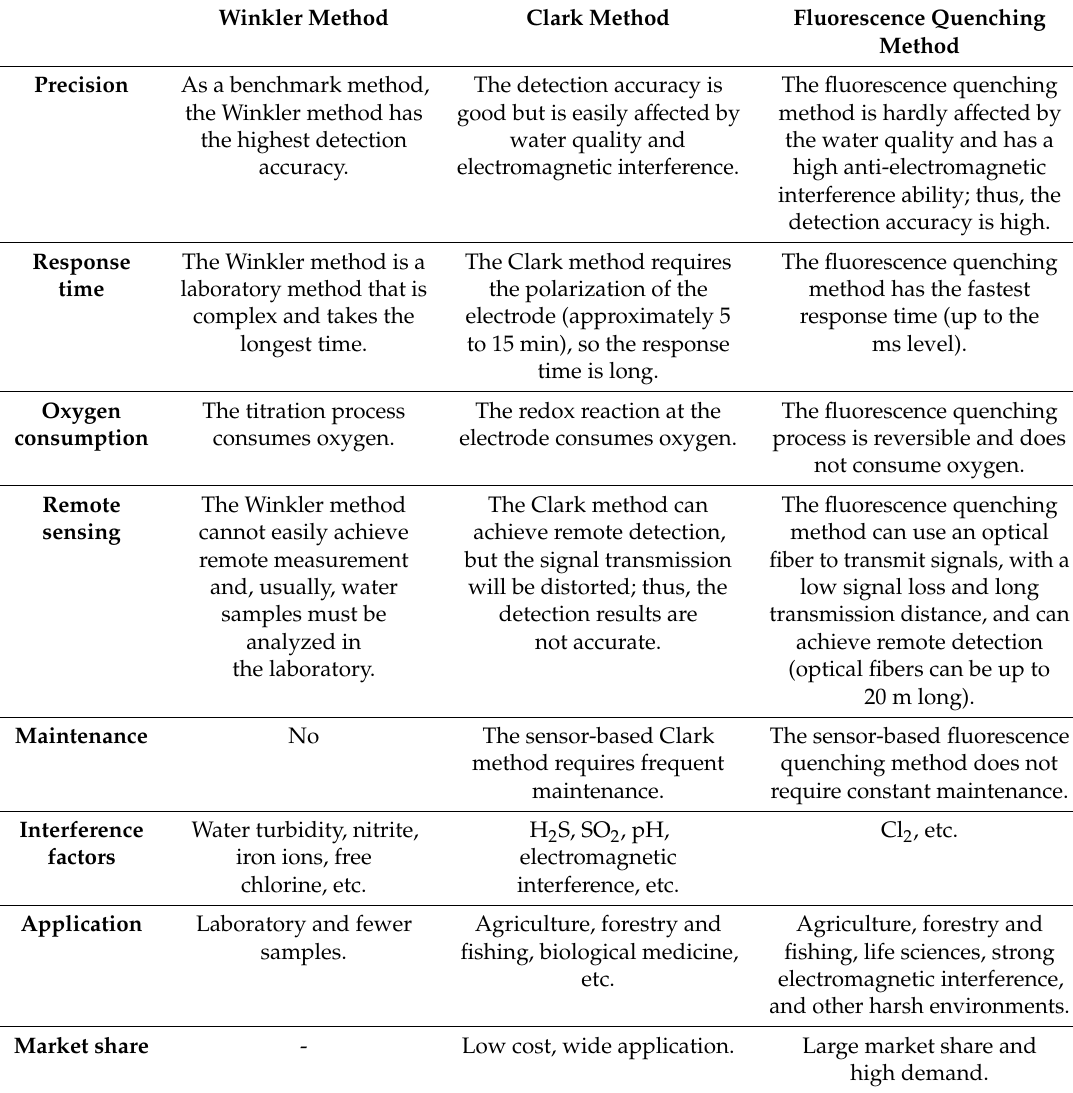
Table 4. Comparison of three methods for the determination of dissolved